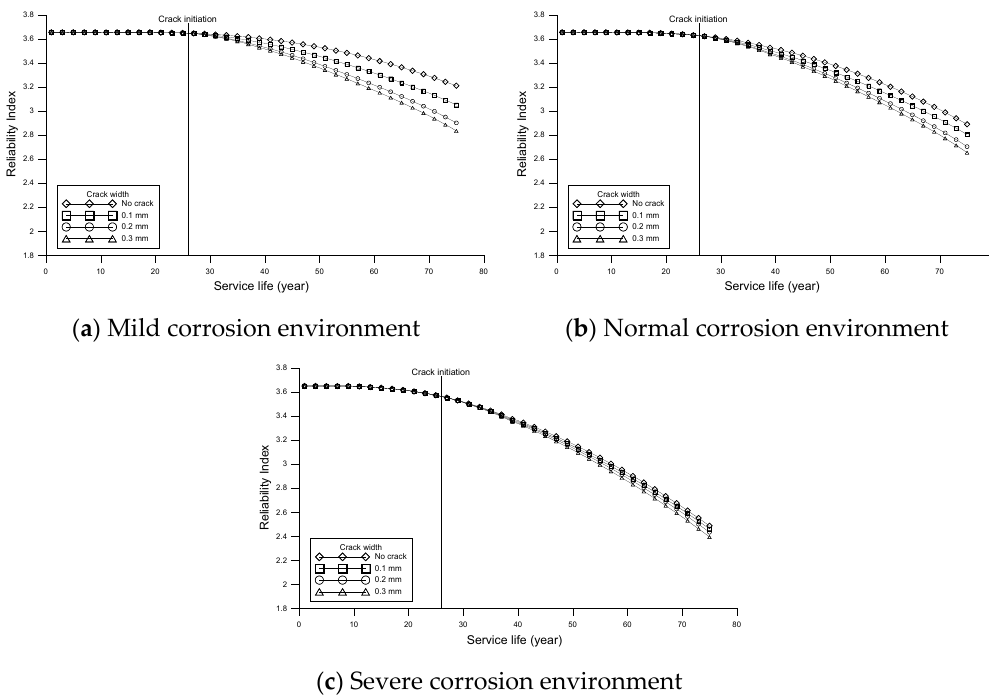
Figure 17. Reliability degradation considering crack width under light traffic characteristics (calibrated model (2-W)).